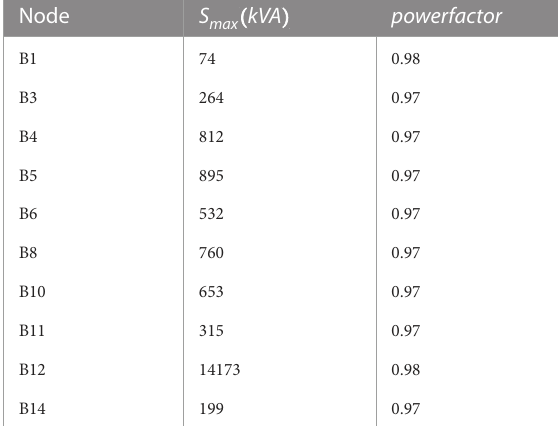
TABLE2 MVdistributionnetworkbenchmarkapplication:Parameters ofresidentialload. Node